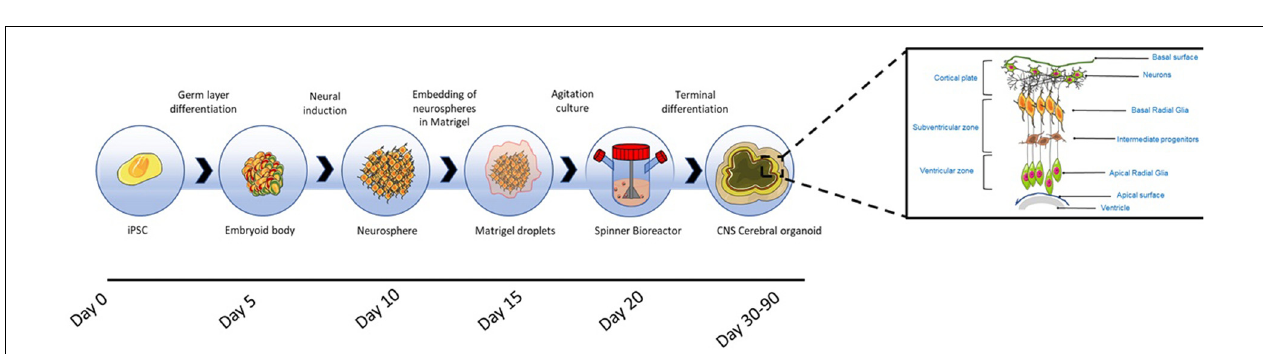
FIGURE 4 | Different brain regional identities recapitulated by CNS organoids. The diagram summarises the various patterning methods developed to generate region specific CNS organoids. Copyright permission was obtained for the reproduction of images taken from Lancaster et al. (2013); Muguruma et al. (2015), Pasca et al. (2015); Sakaguchi et al. (2015), Jo et al. (2016); Qian et al. (2016).